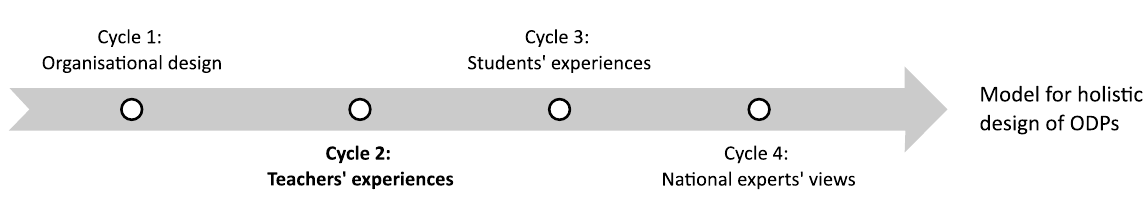
Cycle 2 of the design-based research